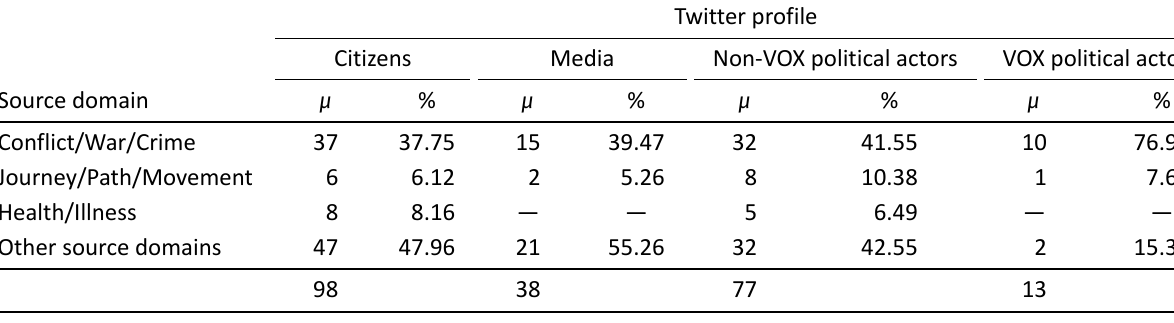
Table 5. Source domain used by Twitter profile for referring to the